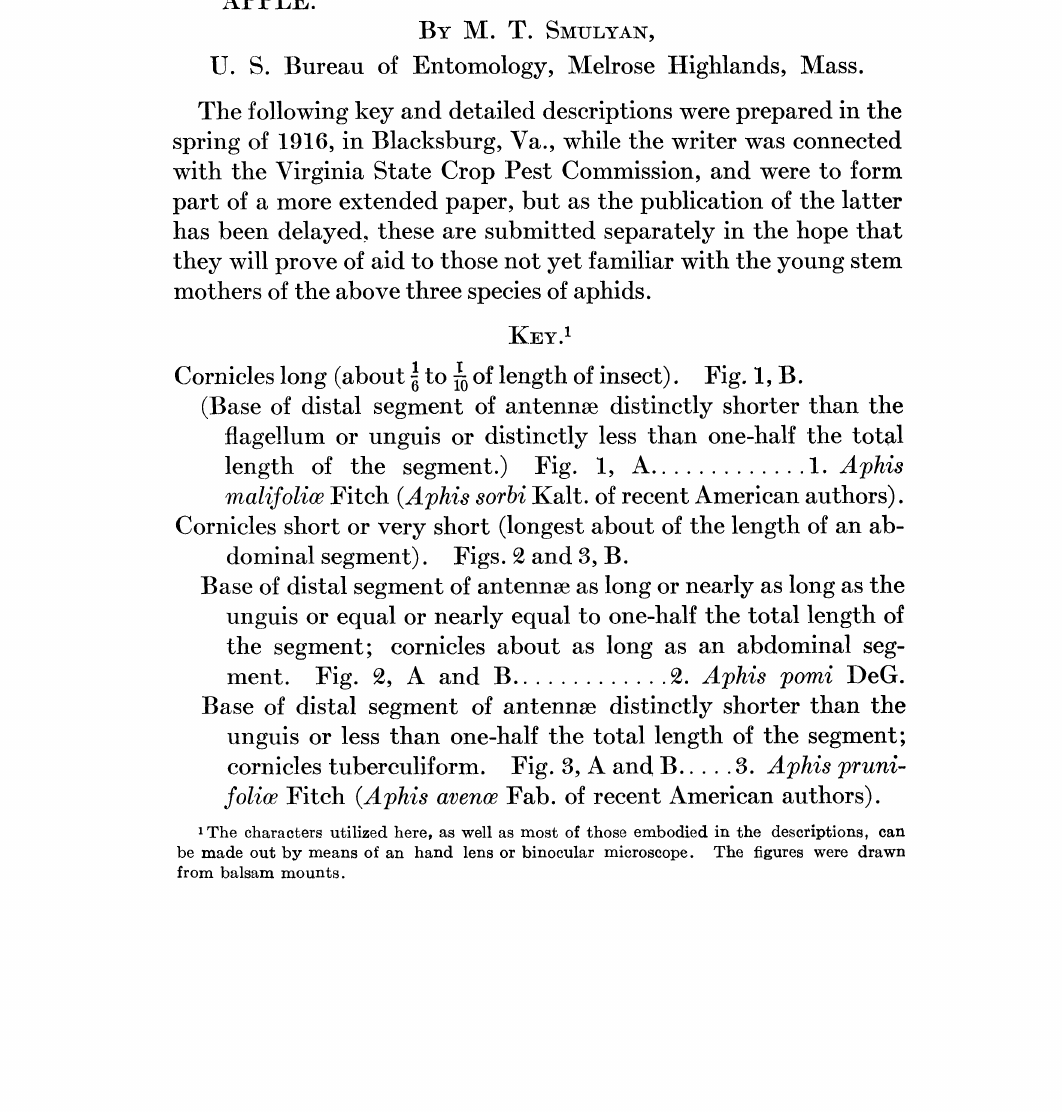
Fig. 8, A and B 8. Aphis